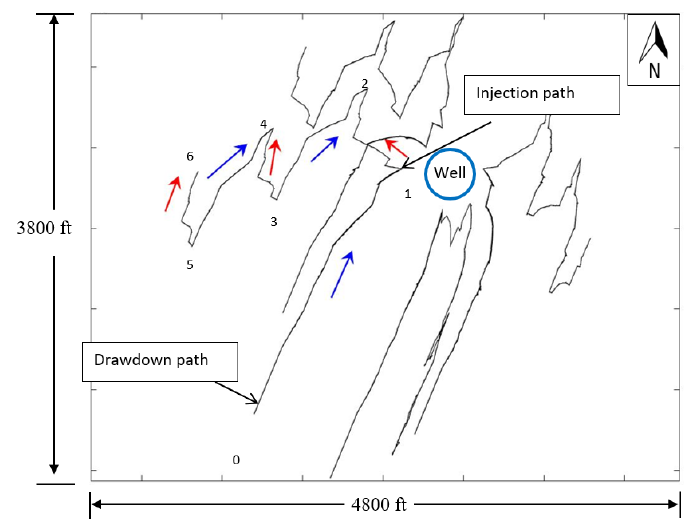
Figure 7. Movement of particles around one representative of eight wells for 6000 days under continuous pumping and injection conditions at the Meadows Pumping Center, CO, USA. The blue and red arrows represent the particle flow directions under pumping and injection processes, respectively. The numbers represent particle positions at the beginning or end of pumping and injection processes.